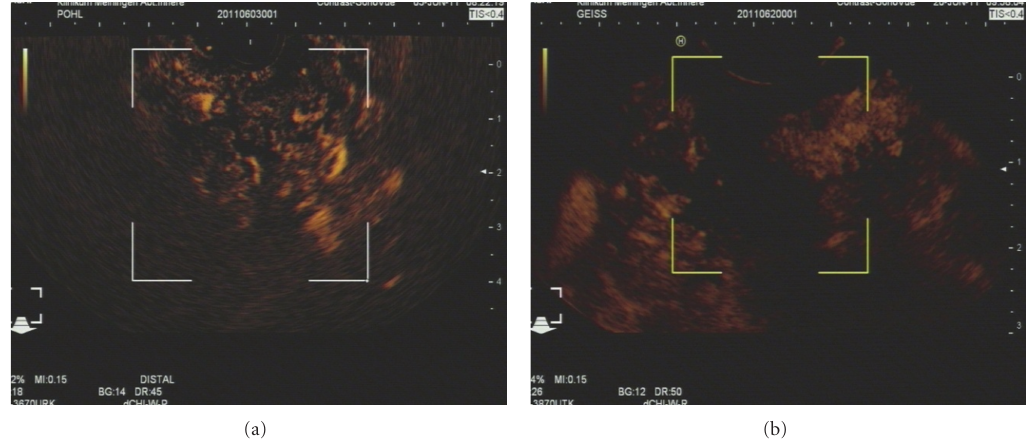
Figure 3: Low mechanical index contrast enhanced endosonography: (a) chronic pancreatitis with a clear enhancement of the contrast enhancer; the lesion is visible inside the markers mostly in the right upper area; all the bright visible spots are contrast enhancer signals (b) pancreatic carcinoma with a lack of contrast enhancer in the lesion; the lesion is visible within the markers; there is a black area without any contrast enhancer signals.